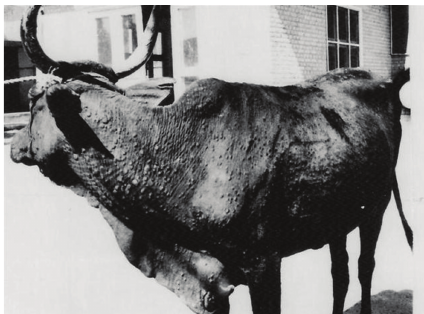
Figure 1: A cow infected with demodectic mange, showing pustules involving the neck, and nodules scattered over the whole body. Note folding of the skin at the base of the